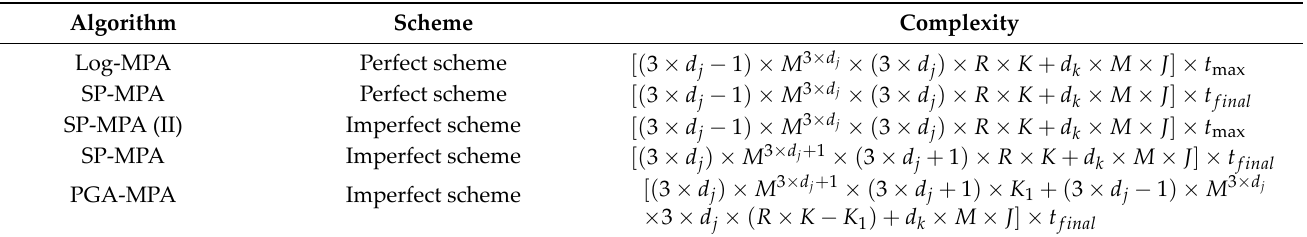
Table 1. Computing complexity in different schemes.